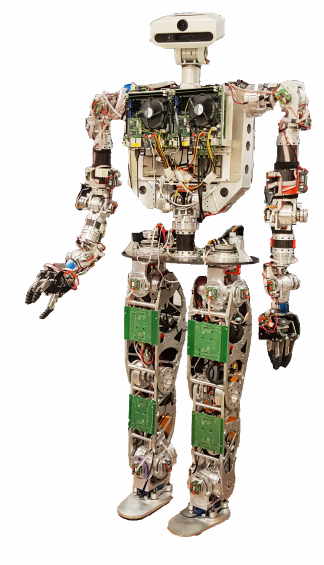
Figure 1. The Task Environment Operator (TEO) humanoid robot from the University Carlos III of